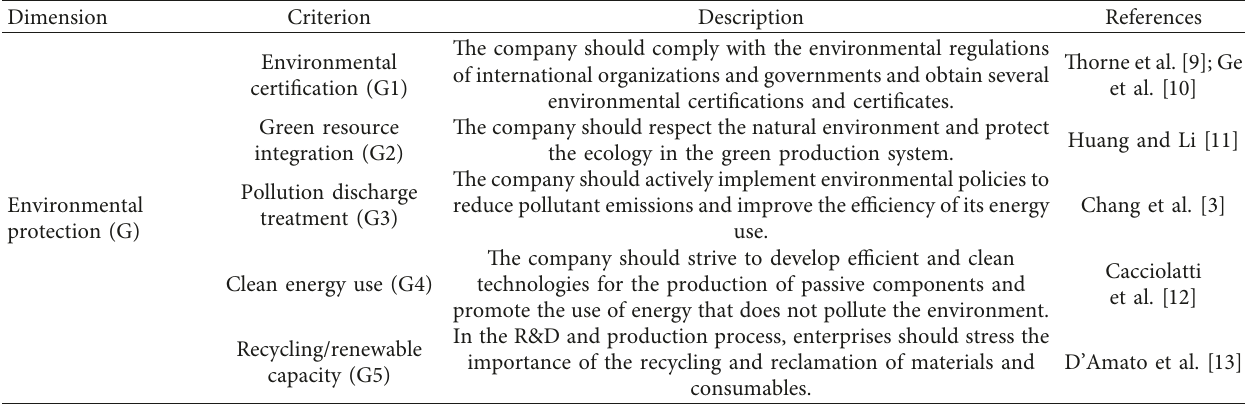
Table 2: The environmental protection dimension and its criteria.